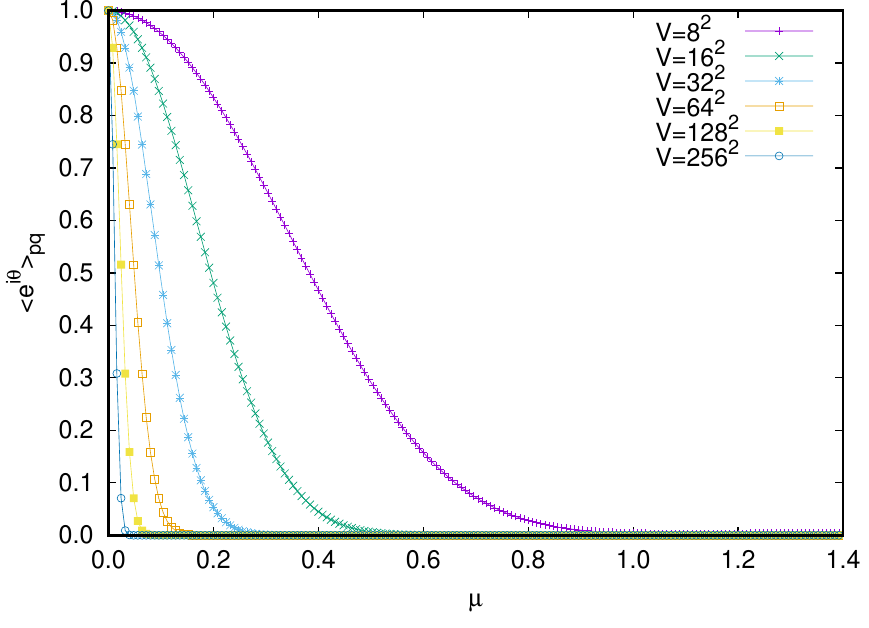
Figure 3 . Average phase factor as a function of (cid:22) . The parameters are m 2 = 0 : 01, (cid:21) = 1, K = D = 64 and V = 8 2 ; 16 2 ; : : : ; 256 2 . The sign problem becomes severe for larger (cid:22) and V